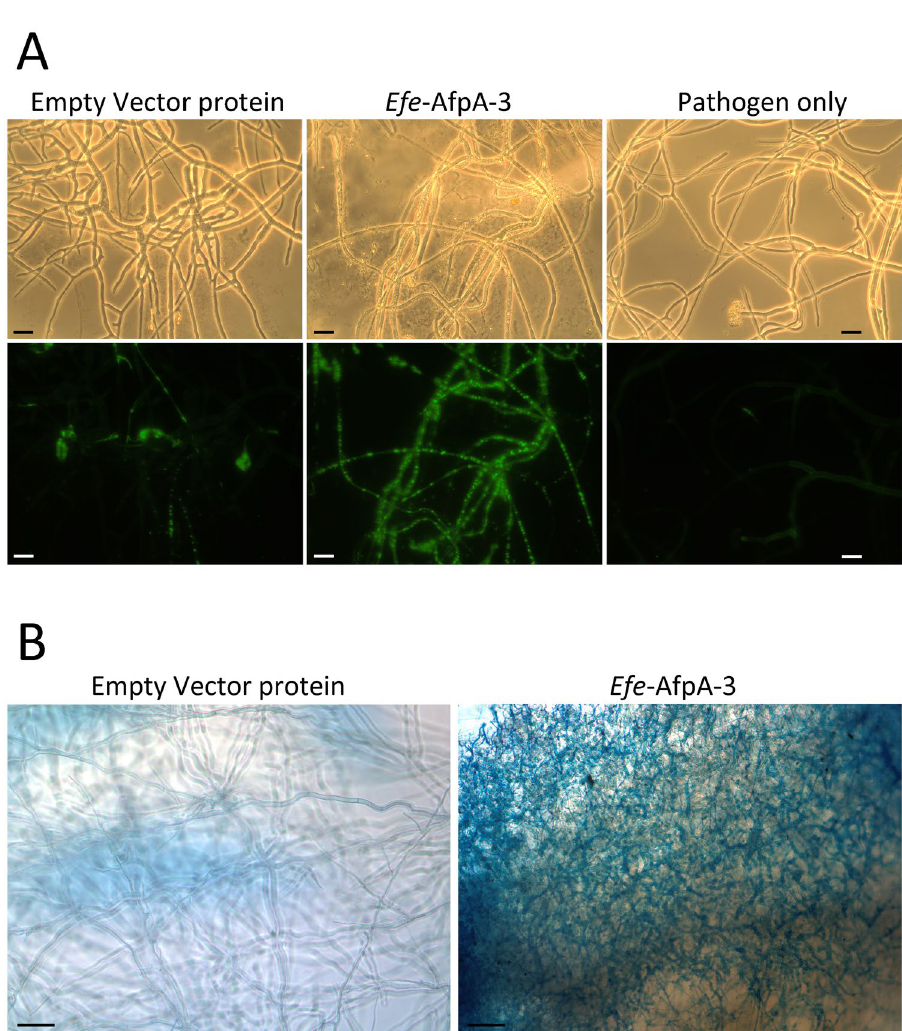
Figure 7. Microscopy of S . homoeocarpa mycelium treated with Efe -AfpA-3 and empty vector proteins purified from the P . pastoris culture filtrates. ( A ) Detection of SYTOX Green uptake by fluorescence microscopy. S . homoeocarpa was cultivated in PDB for 2 d, and 17 μ g of Efe -AfpA-3 or empty vector proteins were added. After 2 h of incubation, fluorescence microscopy was examined in the presence of 12 μ M SYTOX Green. The upper panels are bright-field images and the lower panels are fluorescence images of the same fields. The scale bar is 20 μ m. ( B ) Detection of Evans blue uptake by light microscopy. S . homoeocarpa in the center of a PDA coated microscope slide was treated with Efe -AfpA-3 or empty vector proteins for 1 d and then stained with Evans blue. The scale bar is 100 μ